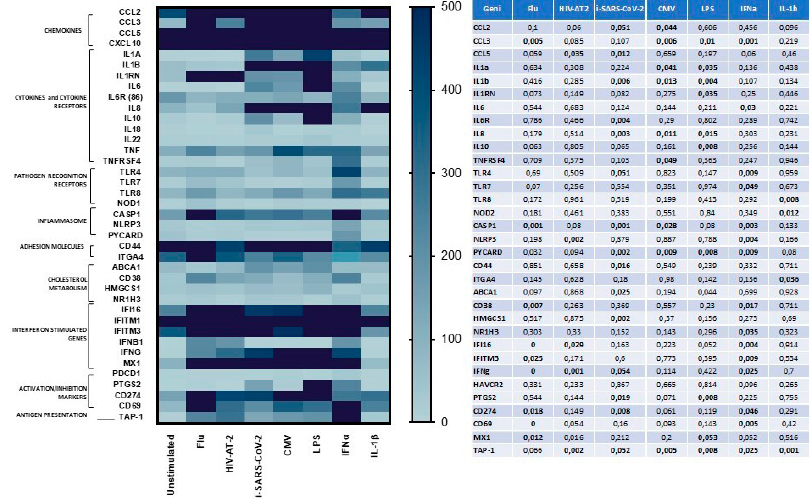
Figure 3. mRNA expression of genes involved in the anti-microbial immune response was modulated in response to di ff erent pathogens. Quantigene Plex Gene expression technology was applied to quantify gene expression on PBMCs isolated from 8 HeteroAB and 6 HomoB individuals and stimulated with microbial antigens (flu, CMV) inactivated viruses (i-SARS-CoV-2, HIV-AT-2) bacterial by-products (LPS) or inflammatory stimuli (IFN α , IL-1 β ). Gene expression (mean values) is shown as a color scale from white to blue (Heatmap). Only statistically significant p values from T-test comparison between unstimulated and stimulated PBMCs are shown in table.